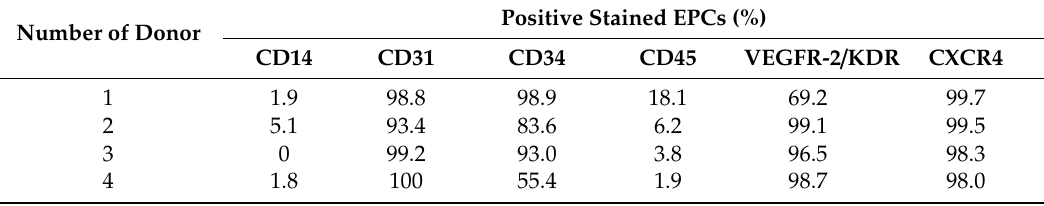
Table 1. Flow cytometry analysis of primary EPCs. Quantitative FACS analysis of EPCs isolated from all